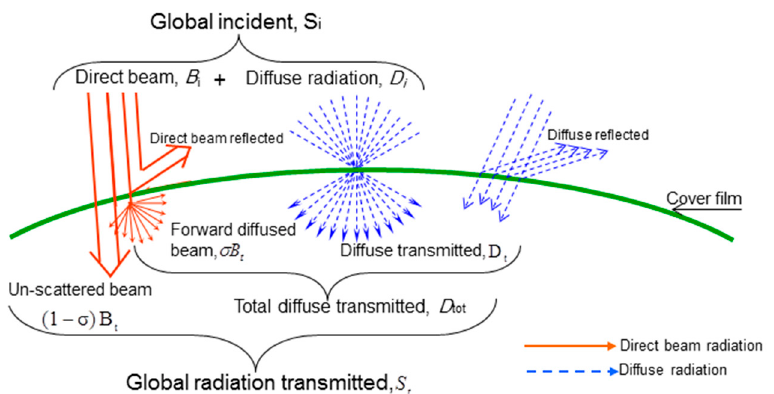
Figure 1. Schematic diagram showing the transmission mechanism and the components of solar radiation transmitted through a plastic film.